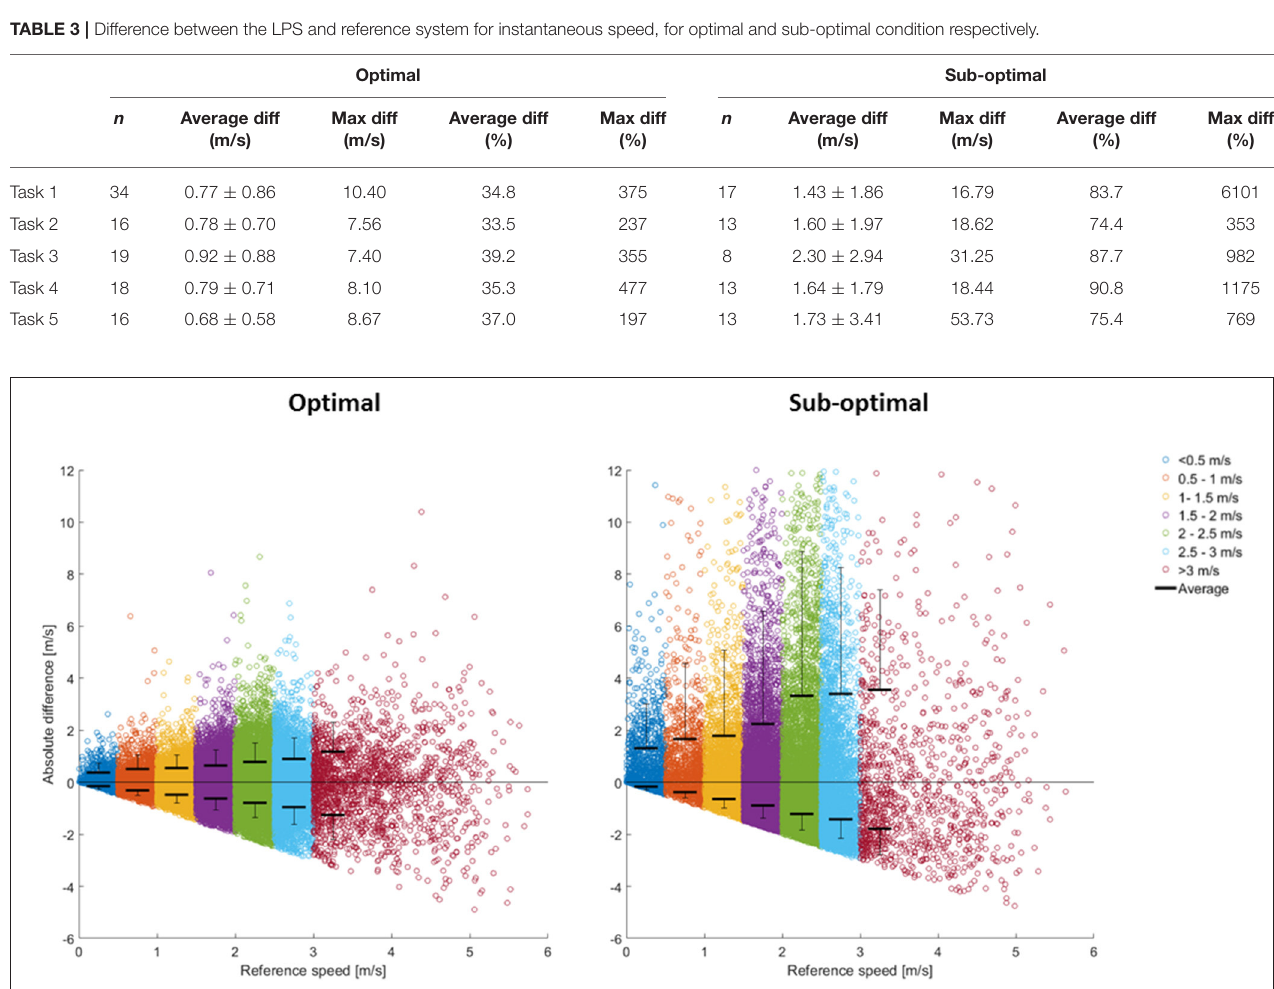
FIGURE 4 | Differences in instantaneous speed from the reference system, divided into speed